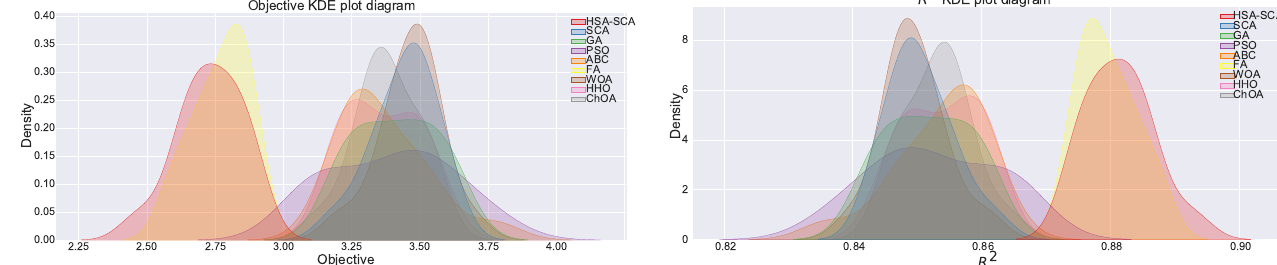
Figure 4. KDE diagrams for MSE ( left ) and R 2 indicator ( right ).